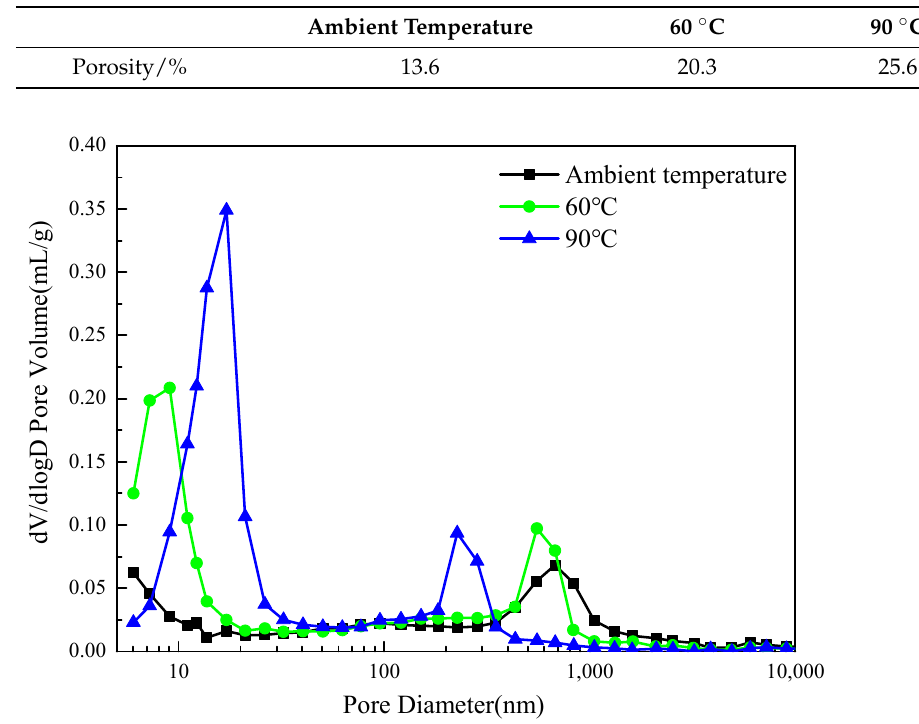
Figure 9. Pore size distribution of HMGC under different curing temperatures.